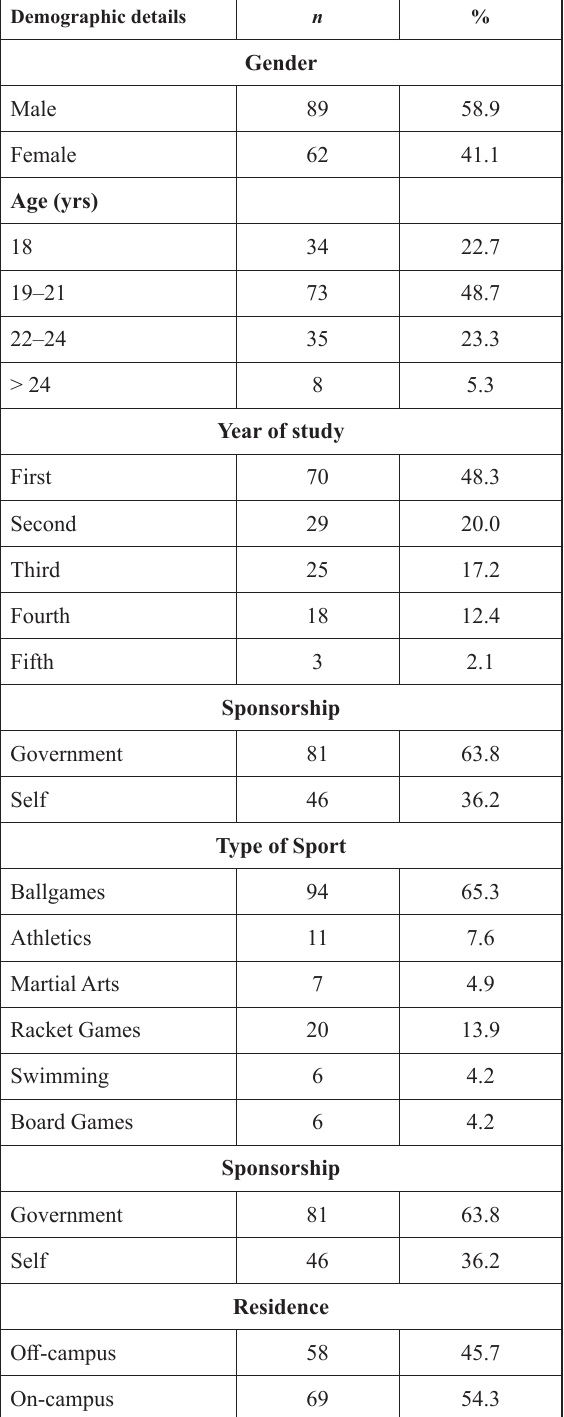
Table 1. Demographic details of the participants ( n =